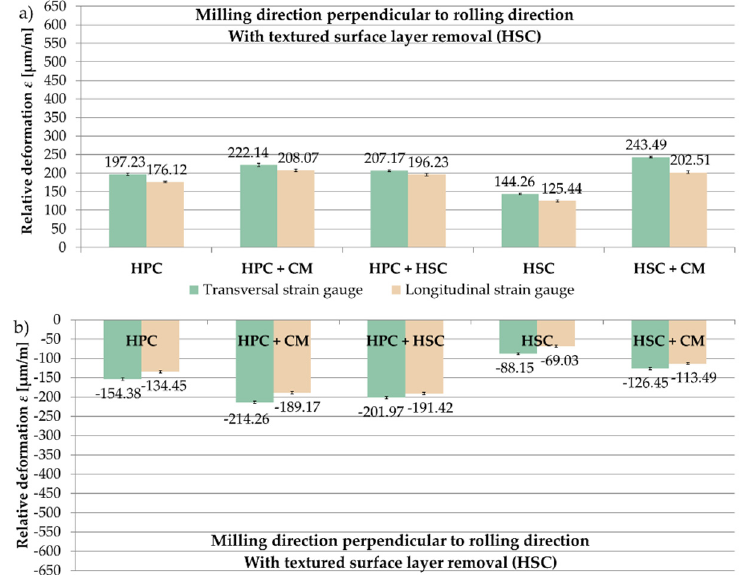
Figure 10. Relative deformation ε obtained for samples in which the textured surface layer (HSC) was removed, the analysed cutting strategies and the relation of the milling direction to the rolling direction: ( a ) perpendicular, ( b ) parallel.